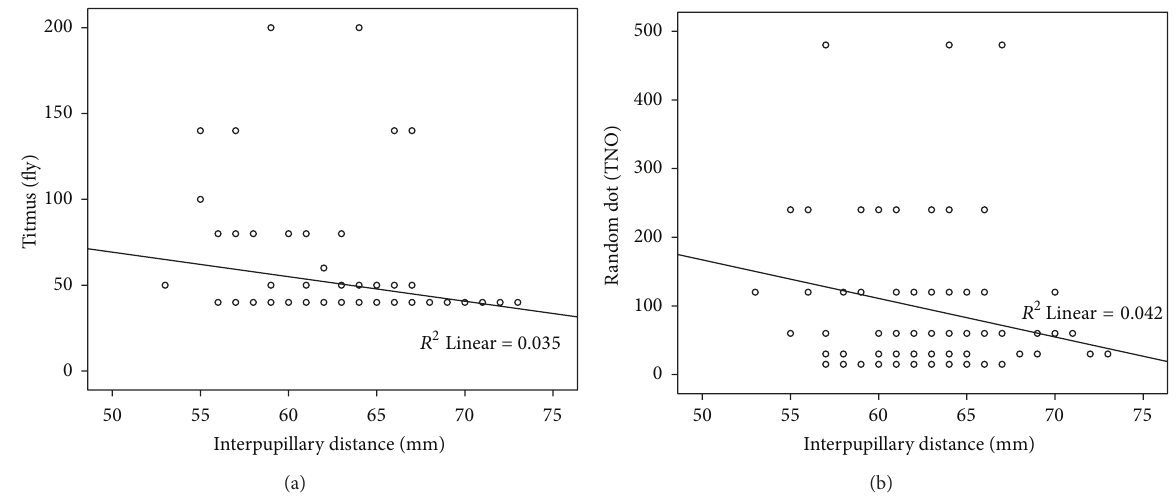
Figure 2: Correlation with interpupillary distance and stereopsis scores in Titmus and TNO tests. Stereopsis scores are increased with interpupillary distance.